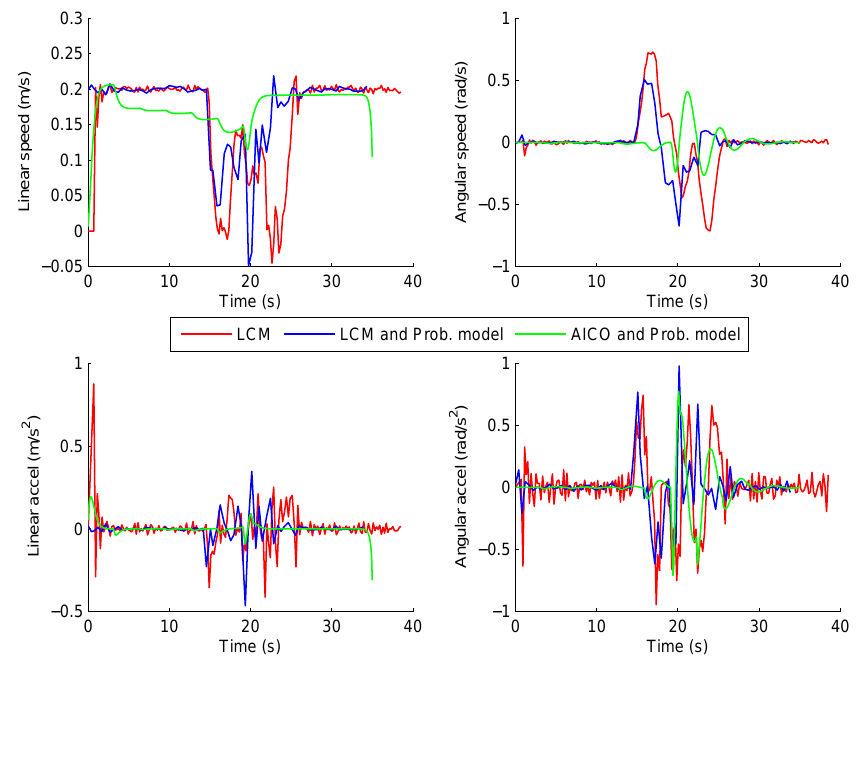
Figure 11. Velocities and accelerations using LCM and AICO: perpendicular